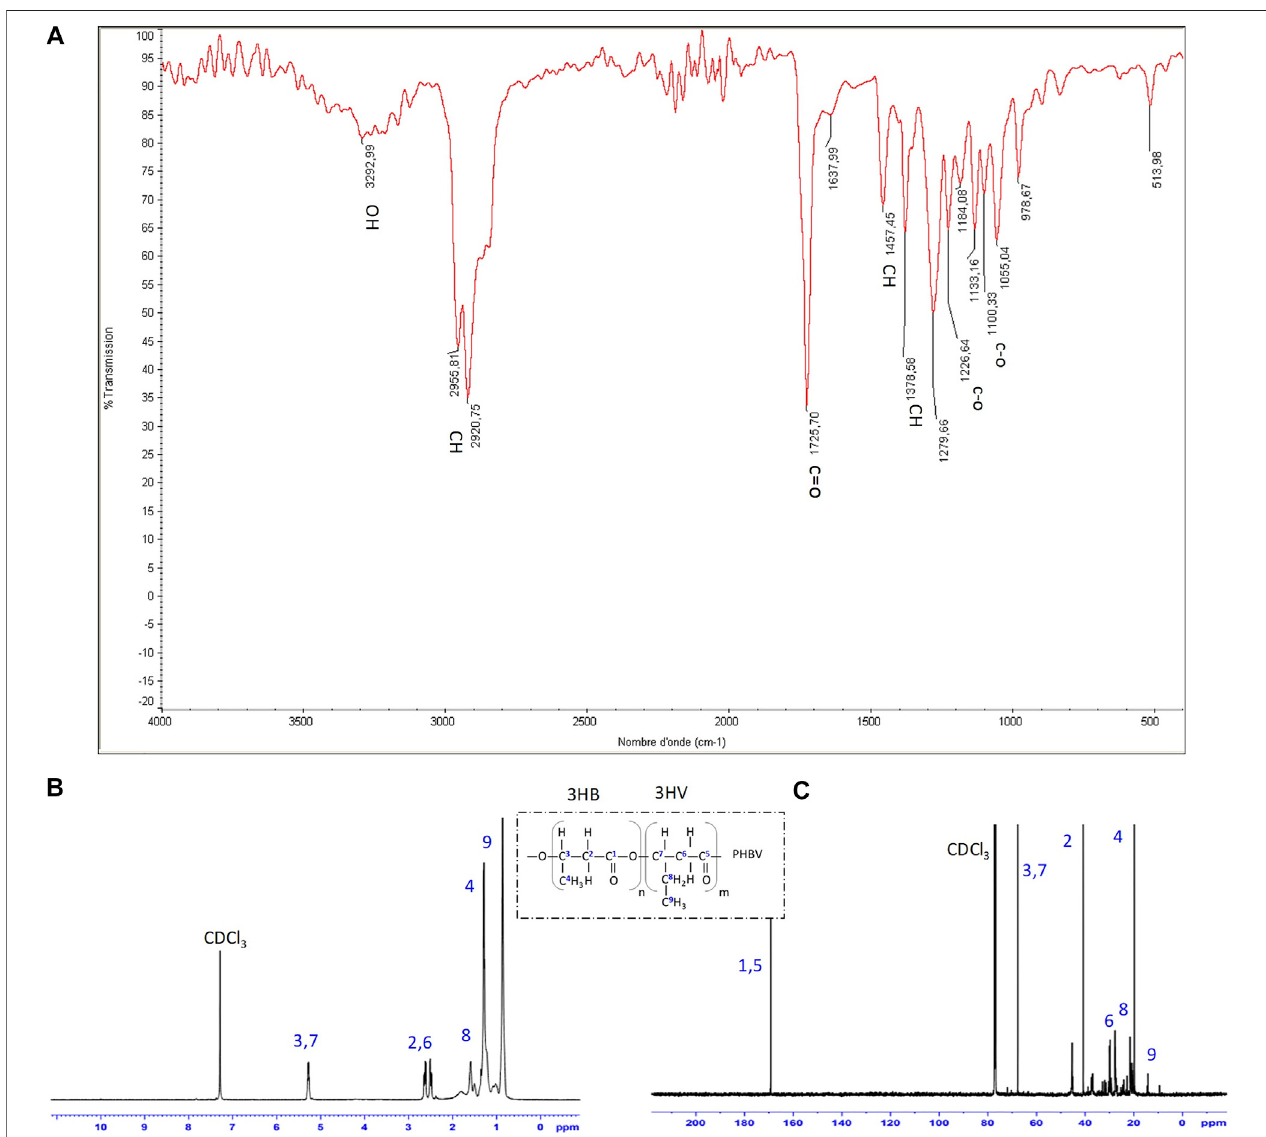
FIGURE 4 | (A) FTIR (B) 1H-NMR and (C) 13C-NMR spectra of puri fi ed PHBV isolated from strain G11 grown on glycerol (5%, v/w) as a carbon